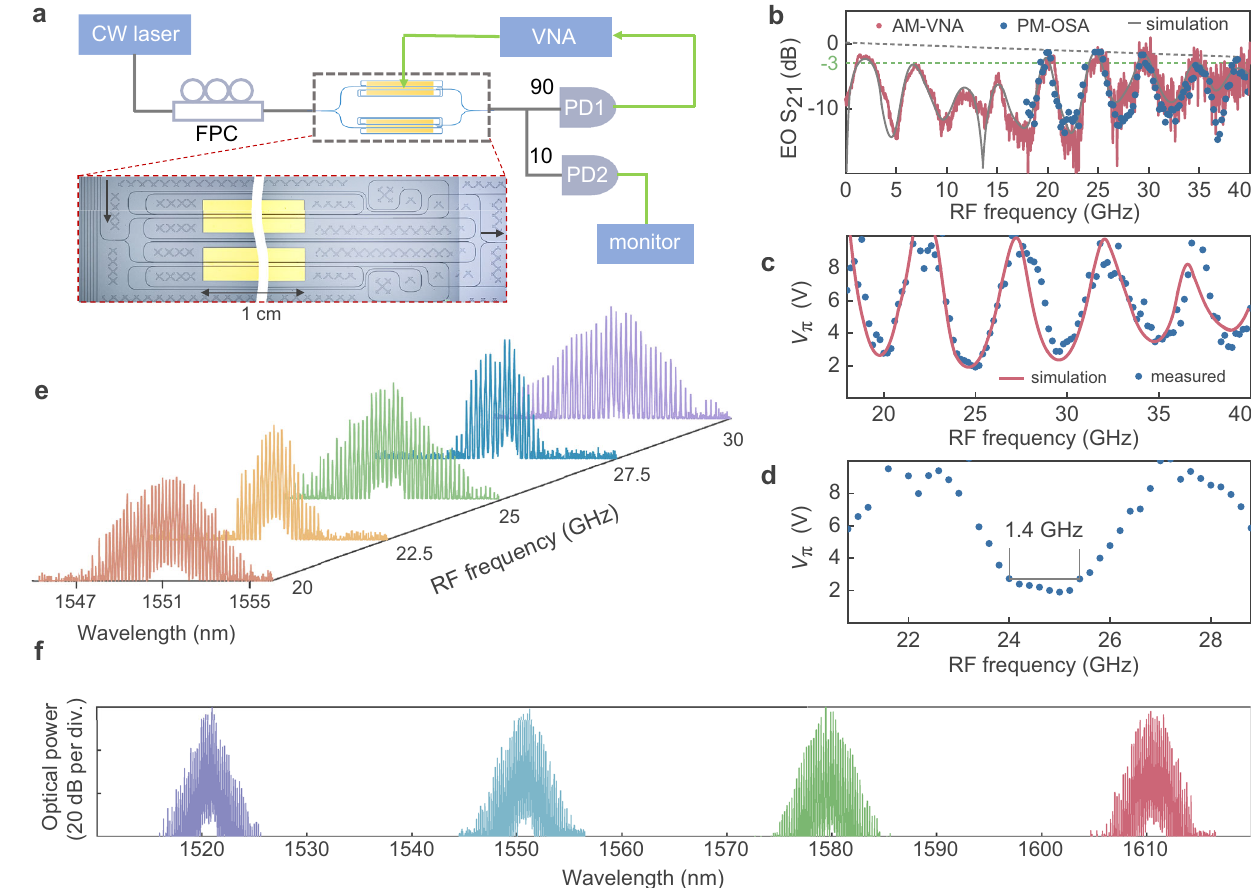
Fig. 4 Tunability characterization of the electro-optic (EO) comb generator. a Experimental setup for direct EO response measurement using a Mach – Zehnder interferometer (MZI) formed by two multi-loop phase modulators (inset: microscope image of the device). b Measured EO response S 21 from amplitude modulation of the MZI device (red dots) and from phase modulation (blue dots), together with simulated (grey solid curve) values. c Measured (blue dots) and simulated (red curve) half-wave voltage V π as a function of radio-frequency (RF) driving frequencies. Measured results see a standard deviation of 5%, and are smaller than blue dot symbols. d Zoom-in view of the measured V π near 25 GHz, showing a 3-dB tuning bandwidth of ~1.4 GHz. e Measured EO comb spectra at different RF driving frequencies, showing maximal comb span near 20, 25 and 30 GHz. f EO comb generation at different optical pump wavelengths, showing a wide tuning range of operation